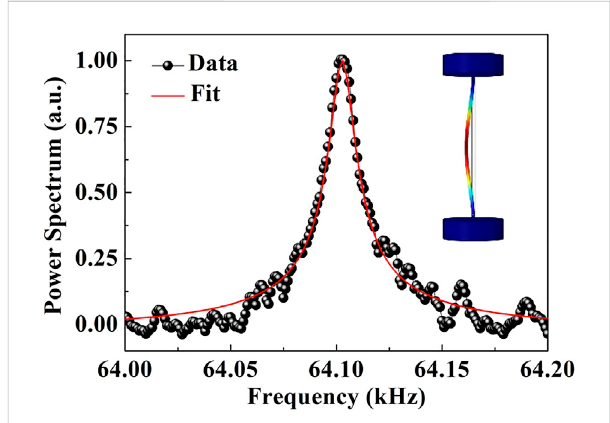
FIGURE 3 Calculated shifts of mechanical resonant frequencies as a function of torsion angle θ .